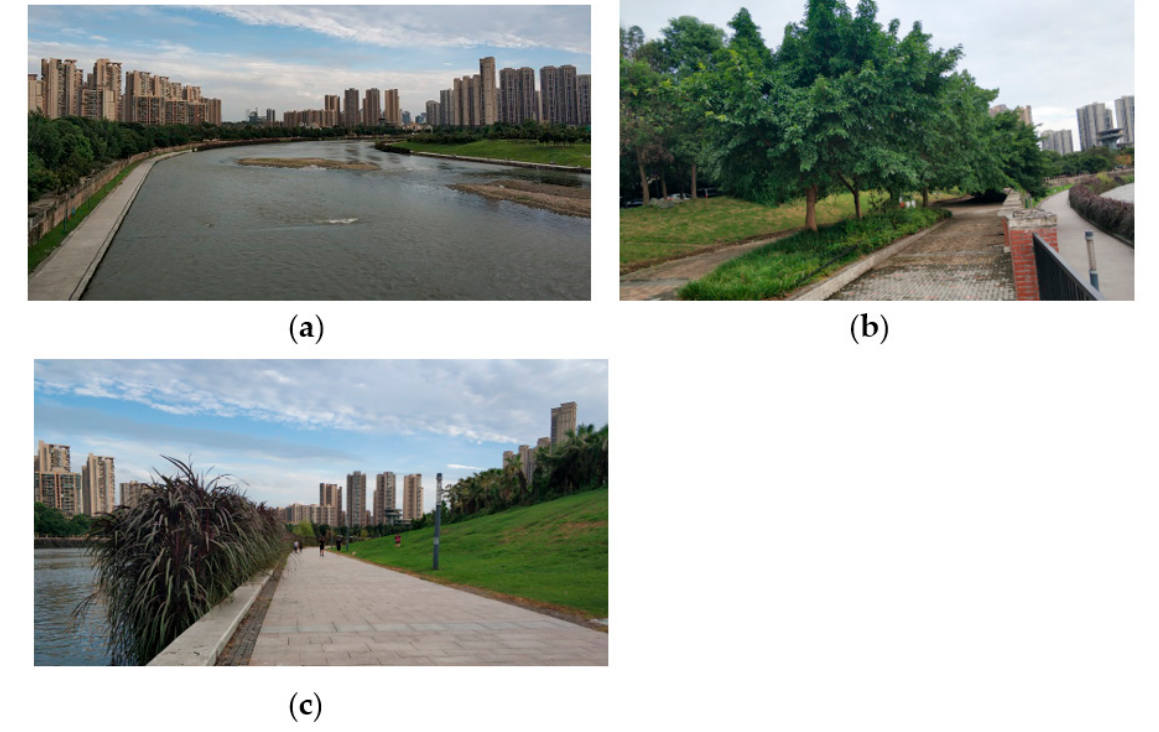
Figure 2. Real-world pictures of the study area: ( a ) overall overview of the study area, ( b ) right bank, and ( c ) left bank.